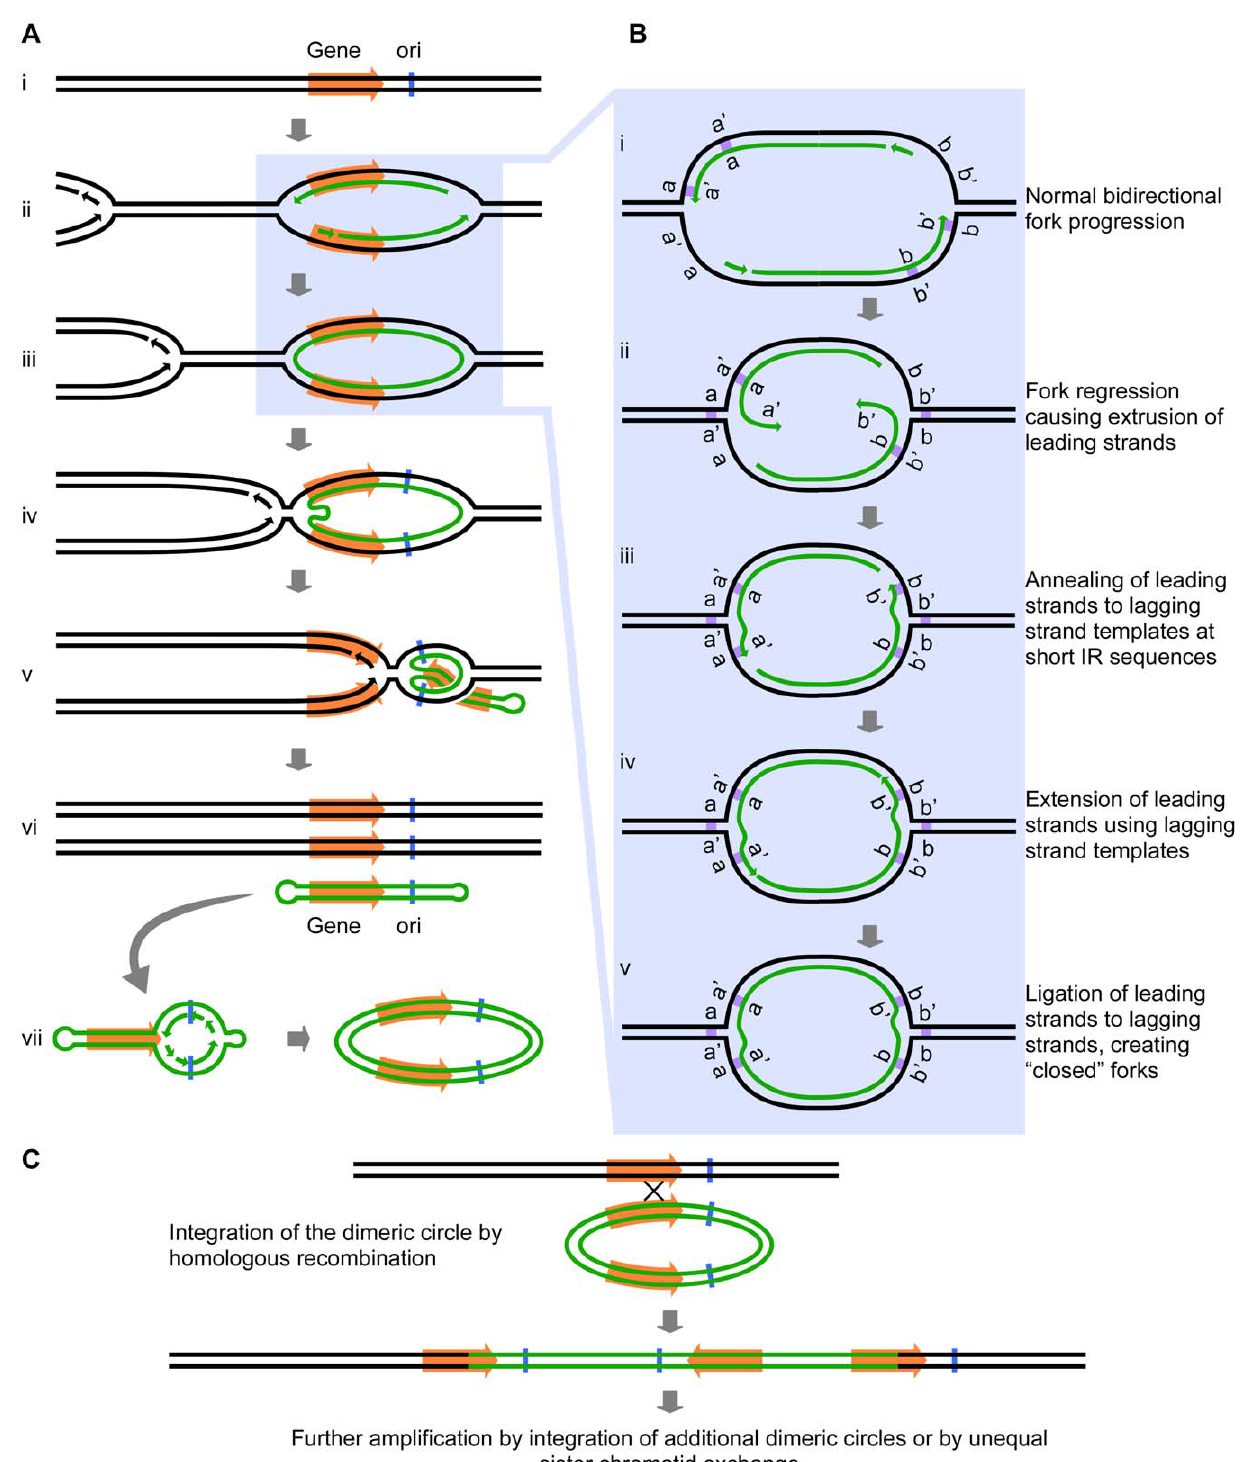
Figure 2. The Origin-Dependent Inverted-Repeat (ODIRA) model for Amplification of chromosomal segments. (A) An overview of the release of a closed circular, self-complementary intermediate that arises from aberrant replication. (B) Details of the mechanism that leads to ligation of the leading and lagging strands at short, closely spaced, inverted repeats (IRs; labeled as a a 9 and b b 9 ). (C) Replication and reinsertion of the inverted dimeric amplicon into the genome by homologous recombination. See text for detailed explanations.